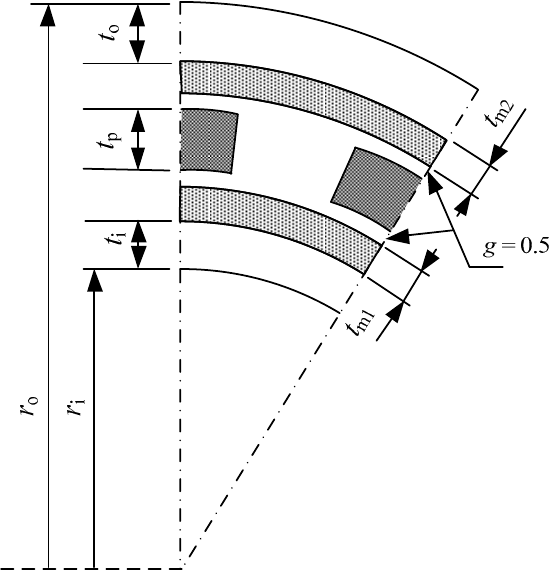
Figure 2. Parameters of surface type of PM concentric magnetic gear.